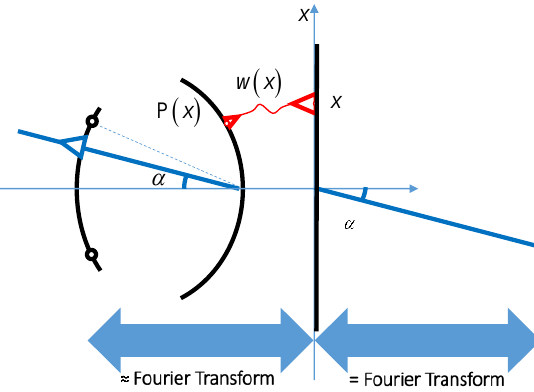
Figure 2. Relation between excitations and far field.